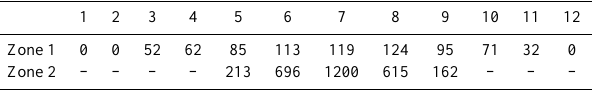
Table 2. The total evapotranspiration capacity of the two lake zones (in millimetres) for each month of the